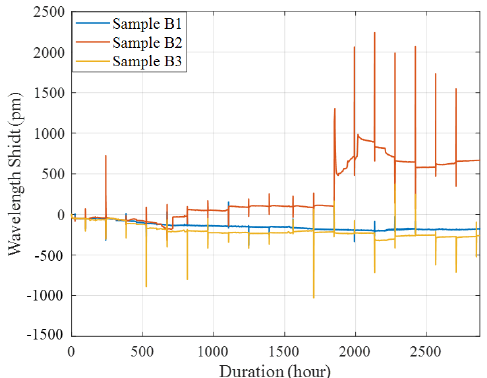
Figure 13. Wavelength shifts of the three tested samples under combined loading–corrosion tests.